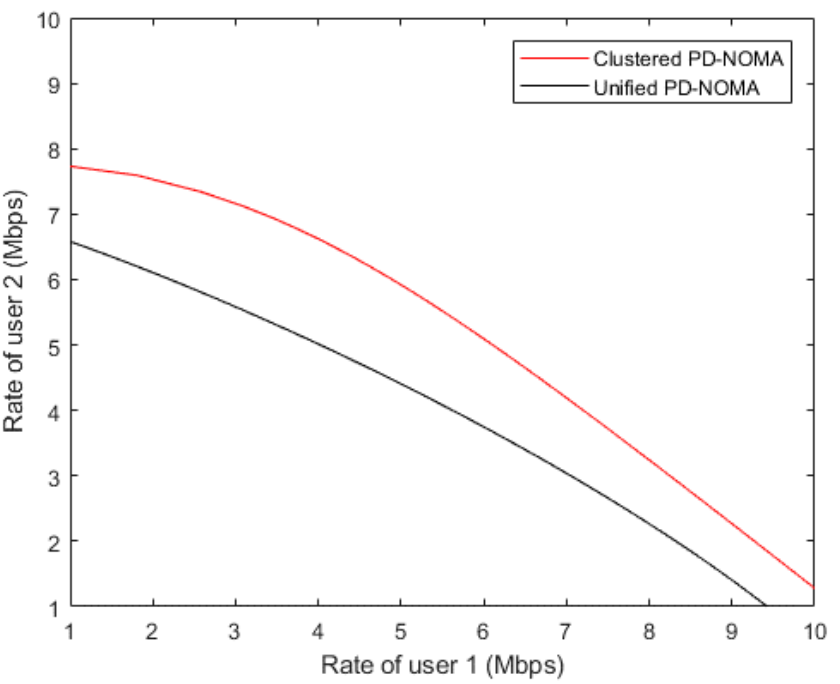
Figure 6. Channel capacity comparison of unified PD-NOMA and clustered PD-NOMA scheme.